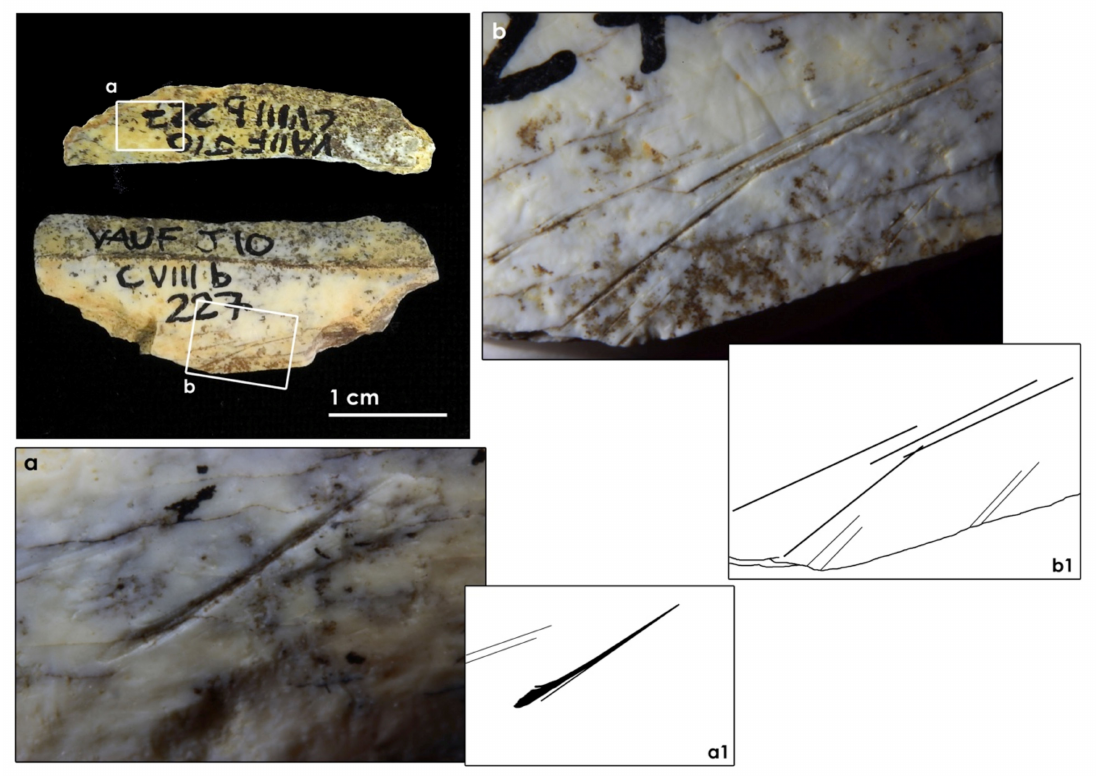
Figure 4. Photo of the large raptor femur shaft with the location ( a , b ) and the scheme ( a1 , b1 ) of the cut marks.